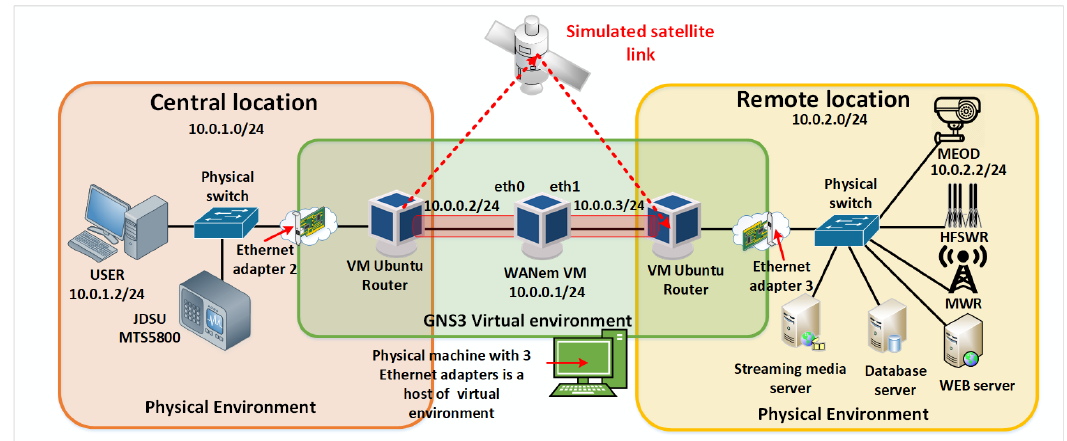
Figure 5. Laboratory for internet of things (IoT) communication infrastructure